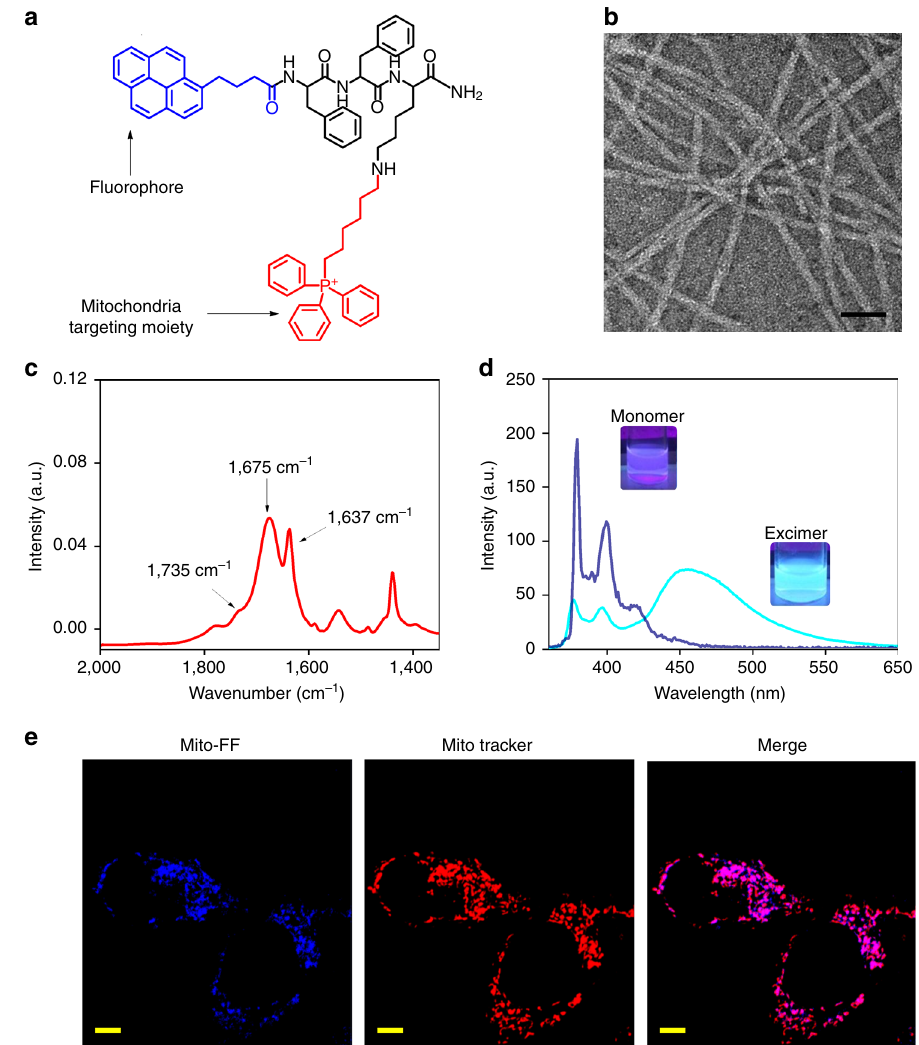
Fig. 2 Self-assembly and mitochondrial localization of Mito-FF. a Structural design of the mitochondria-targeting peptide amphiphile, Mito-FF, which is equipped with a pyrene group for fl uorescence detection inside cells and TPP for targeting of mitochondria. b TEM image of Mito-FF fi bril in water (scale bar, 50 nm). c FT-IR spectra of Mito-FF fi bril showing the β sheet con fi rmation. d Emission spectra for Mito-FF showing the excimeric emission above the CAC ( sky blue line ) and lack of excimer below the CAC ( deep blue line ) (the inset shows optical images of monomeric ( left ) and excimeric ( right ) emission). e Mitochondrial co-localization of Mito-FF measured with MitoTracker Red FM shows high localization inside mitochondria (scale bar, 5 μ